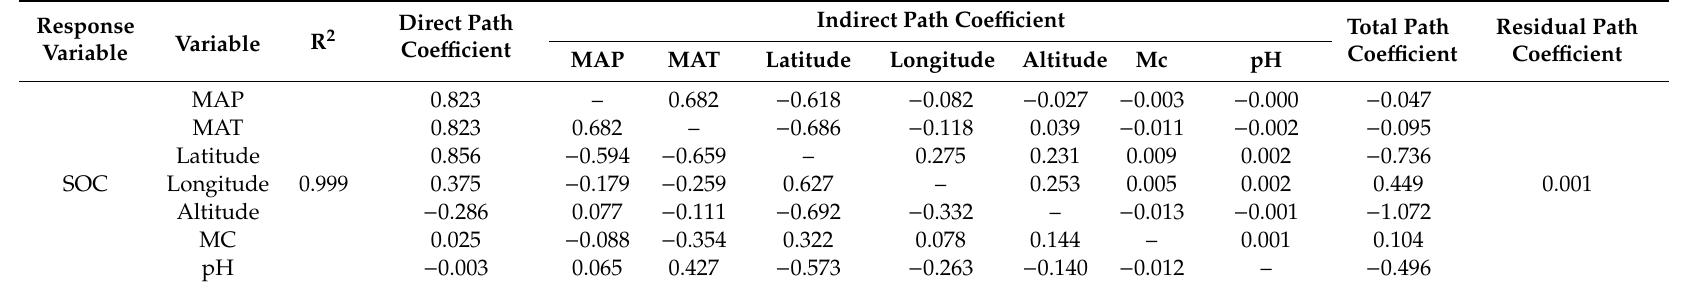
Table 3. PA results between SOC content and environmental